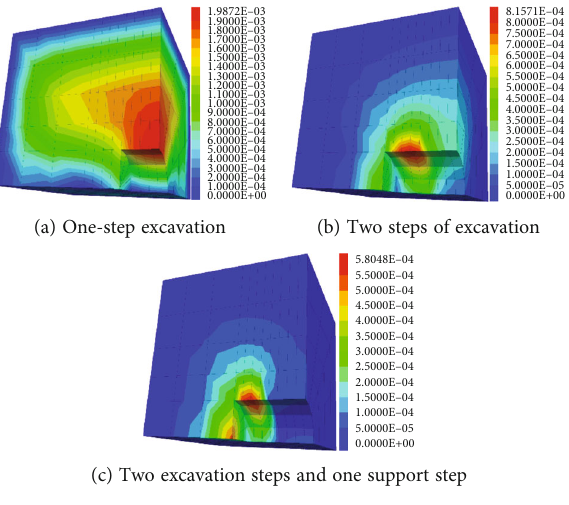
Figure 7: Total displacement cloud